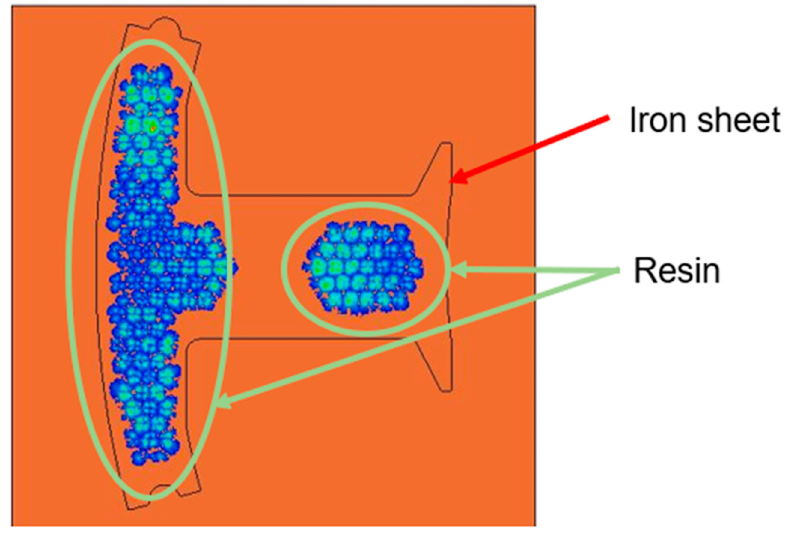
Figure 16. Top view of the dipping process results of Case 2.